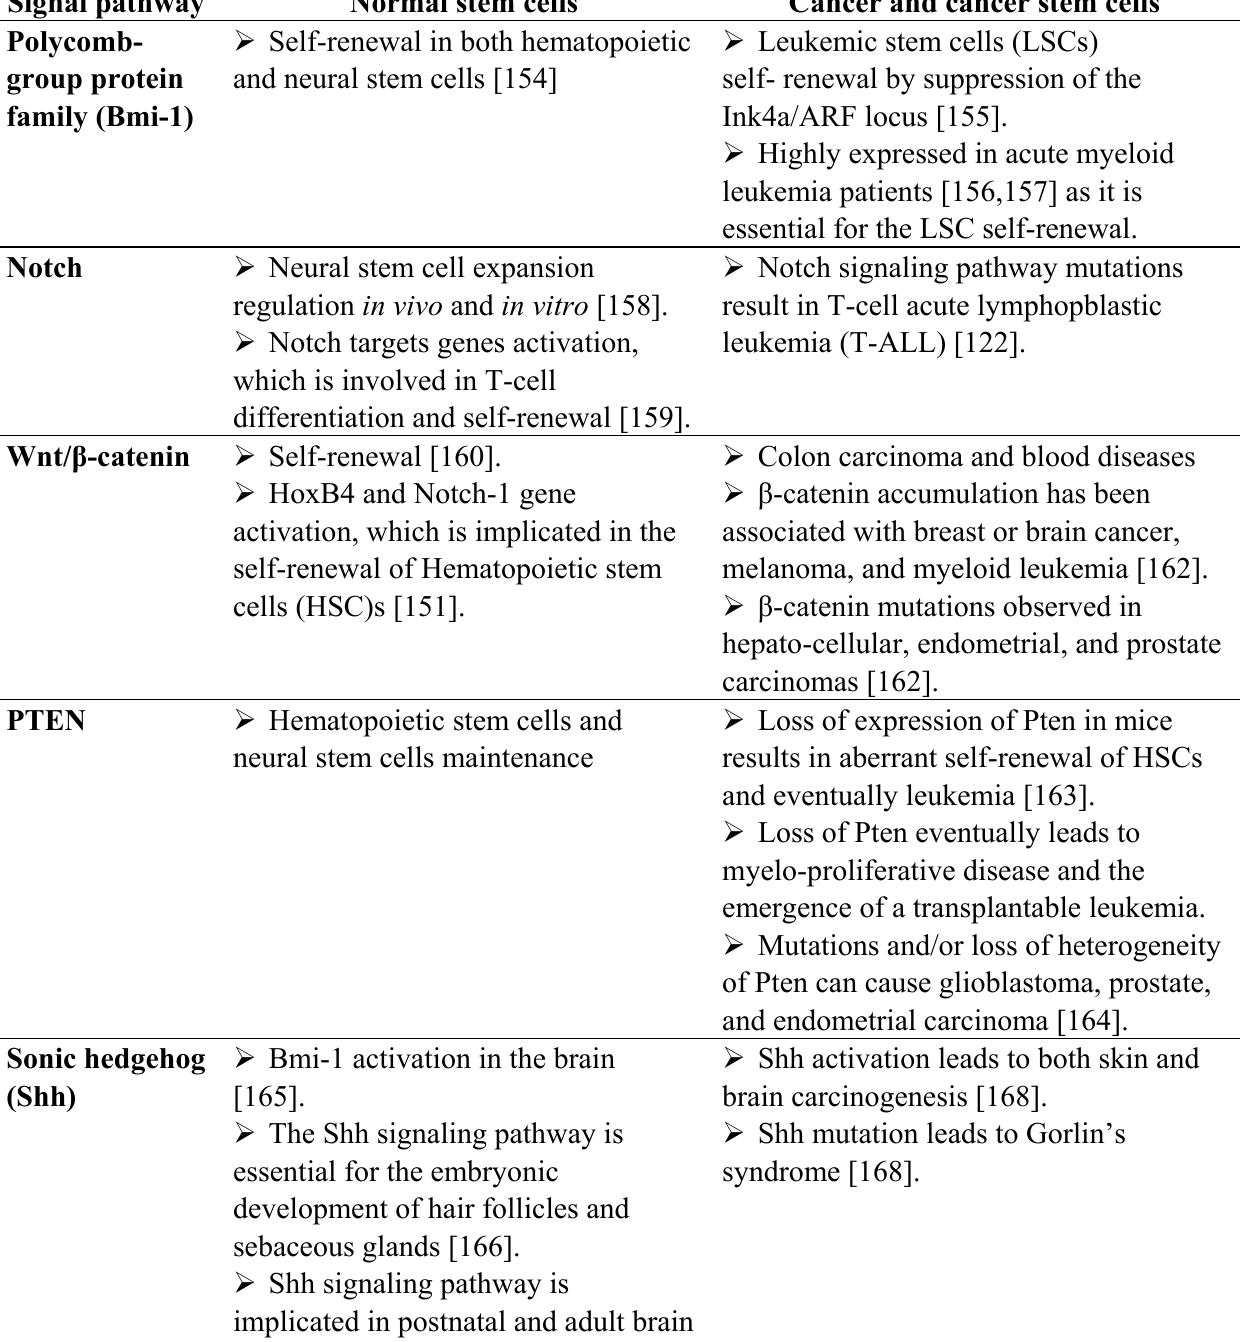
Table 1 . The differences among the cancer cells, cancer stem cells, and normal stem cells in the signaling